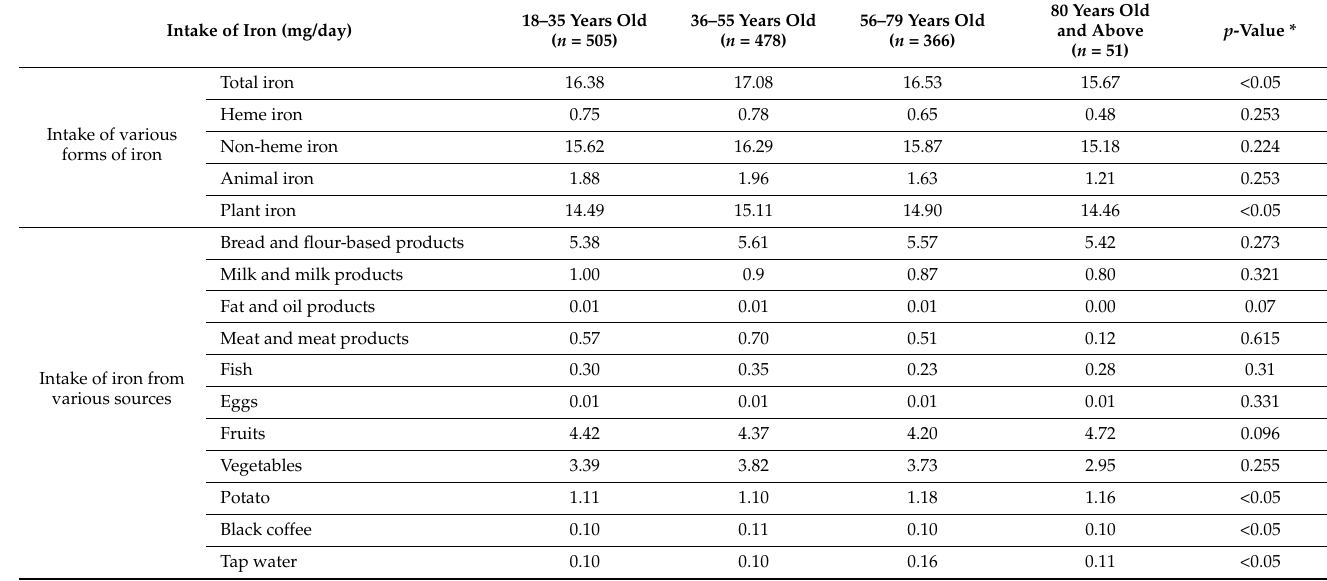
Table 4. Comparison of intake of various forms of iron along with that of iron intake from various sources in the national sample of Armenian adults among different age